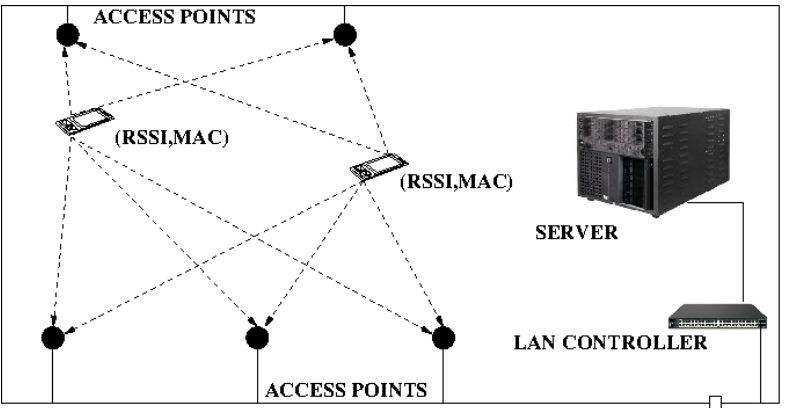
Figure 2. WiFi positioning system. First, the list of Access Points is determined. Second, for each Access Point, all the visible mobile devices are listed. The customer is then located using